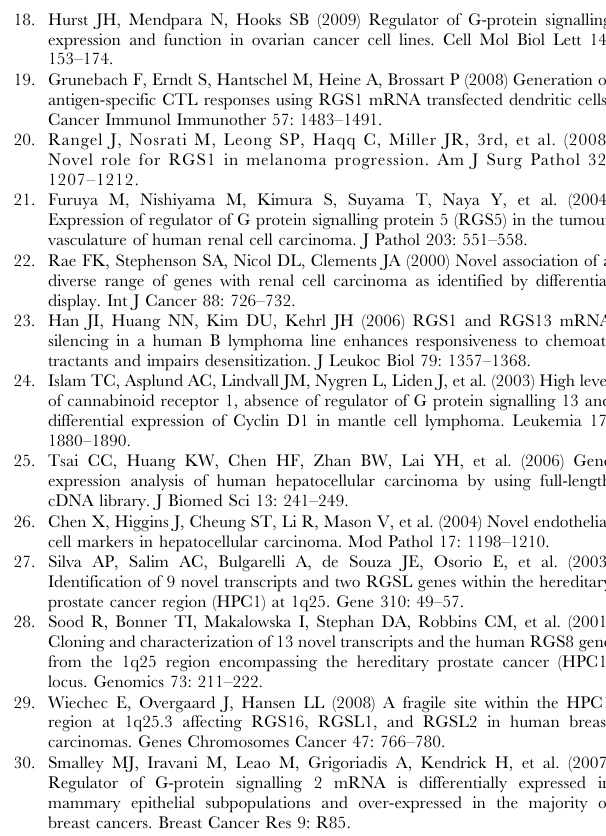
Table S1 NPs in the RGS pathway.